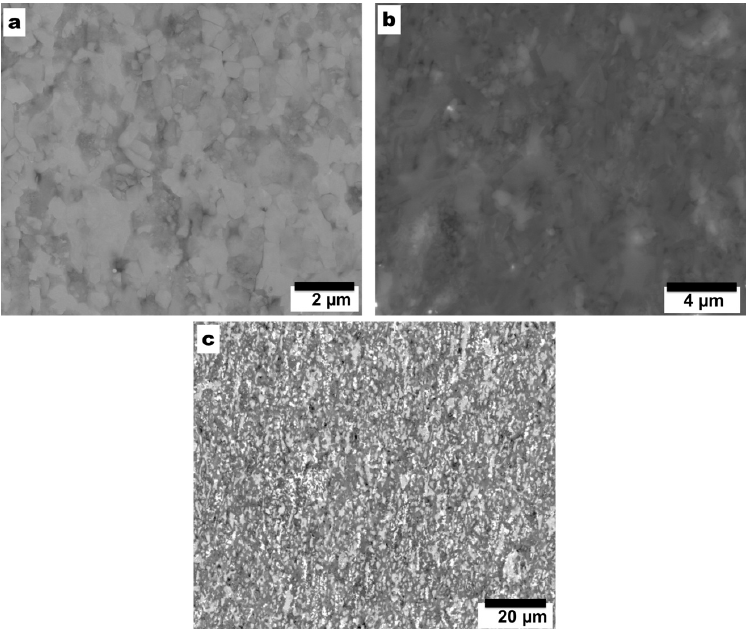
Figure 6. SEM back scattered electron (BSE) images showing the microstructure ( a ) Zr-B; ( b ) Ti-B; and ( c ) 50Zr-50Ti-B.